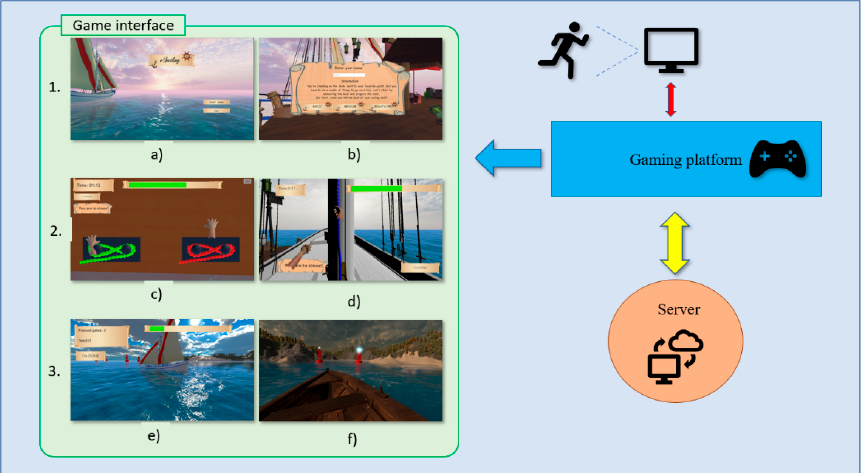
Figure 2. General introduction to the gaming platform. Of the 3 sections in the game platform block: 1—example of the initial information levels such as ( a ) main menu, ( b ) difficulty selection menu and profile creation; 2—example of the first exercise block for upper body, ( c ) Level 1, ( d ) Level 2; 3—example of exercises for lower body and general mobility, ( e ) Level 4, ( f ) Level